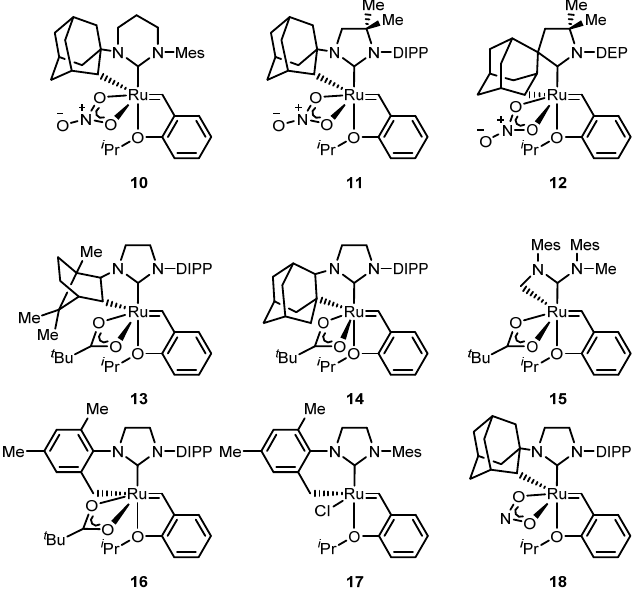
Figure 5. Various cyclometalated catalyst scaffolds evaluated.